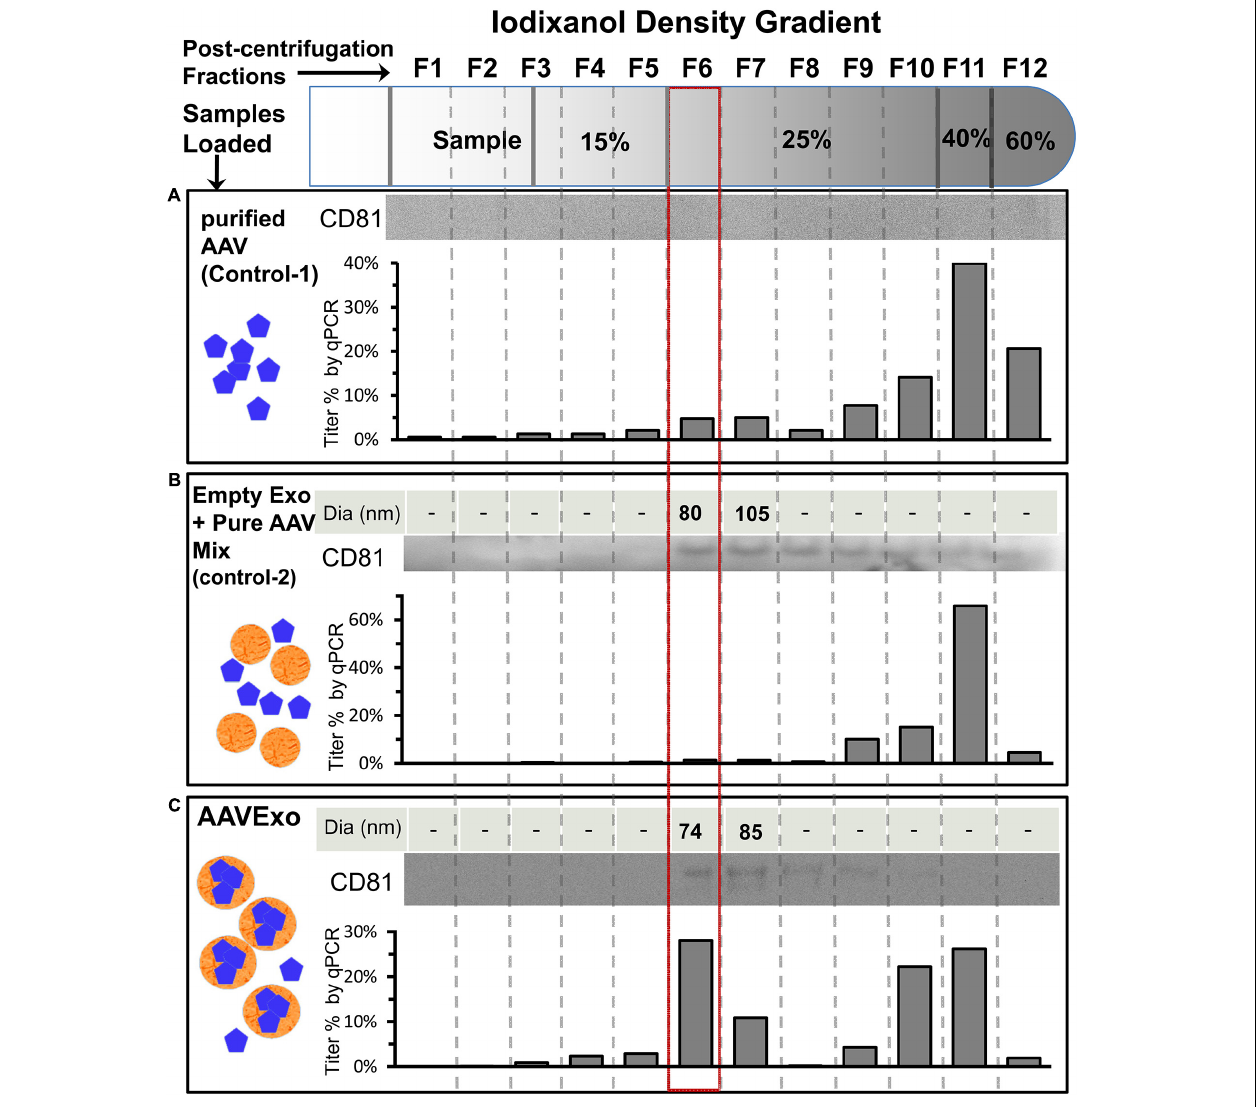
FIGURE 2 | Strategies and characterization of AAVExo purification. Equal titer of pure AAV ( A , control 1), a mixture of empty exo and pure AAV ( B , control-2), and AAVExo (C) crude prep loaded on top of an Optiprep density gradient and ultracentrifuged at 250,000 g for 3 h. Separated fractions were collected from the top as indicated and analyzed for the presence of exosomes [(1) size, by ZetaView; (2) exosomes marker protein, CD81 by WB] and for the presence of AAV (by qPCR). The experiment was biologically reproduced for three times, and the representative results were